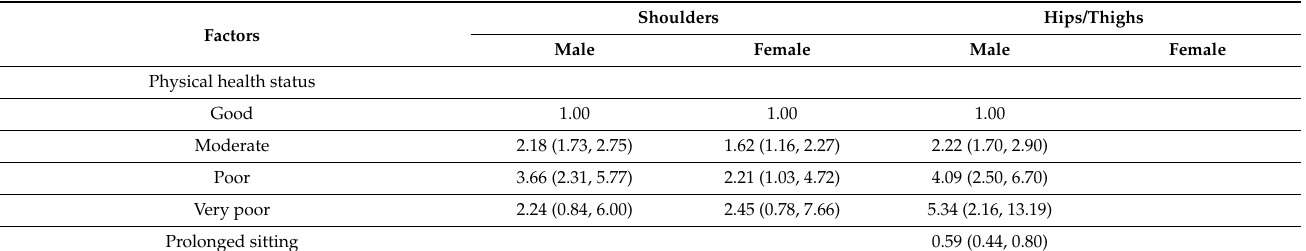
-: not applicable for the body part. Table 4. The adjusted odds ratios (95% CI) of the risk factors for WMSDs in the shoulders and lower